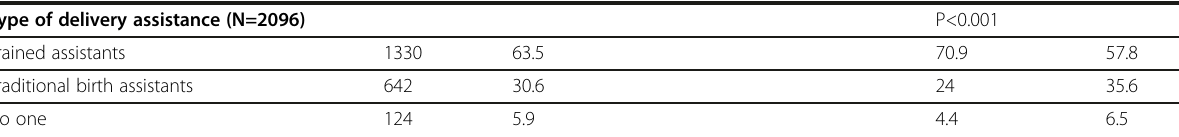
Table 1 Distribution of socio-demographic factors in relation to the timing of antenatal care visit and type of delivery assistance among Ghanaian women